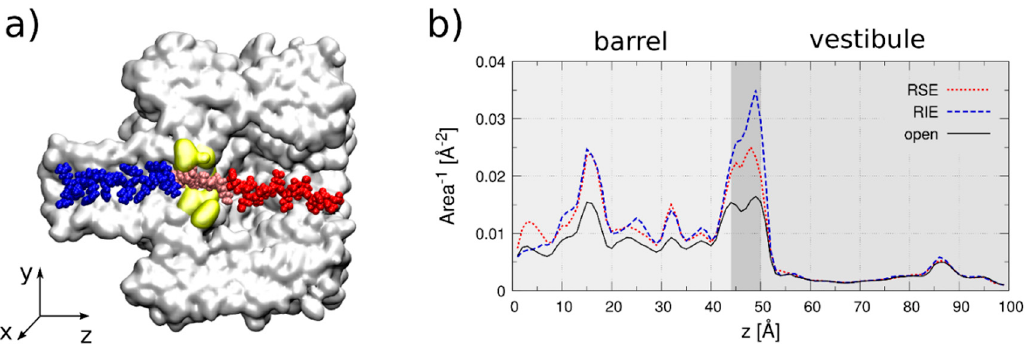
Figure 3. Atomistic simulations. ( a ) Snapshot of the system. Arginine tail is in blue, Glutamic acid in red while the neutral amino acid (Isoleucine, in this case) is in pink and it is in the pore constriction (yellow). Water, ions and lipid membrane are not represented for the sake of clarity. ( b ) The inverse of area available for the electrolyte passage for the open pore and for RIE (Pe4) and RSE (Pe6) cases.